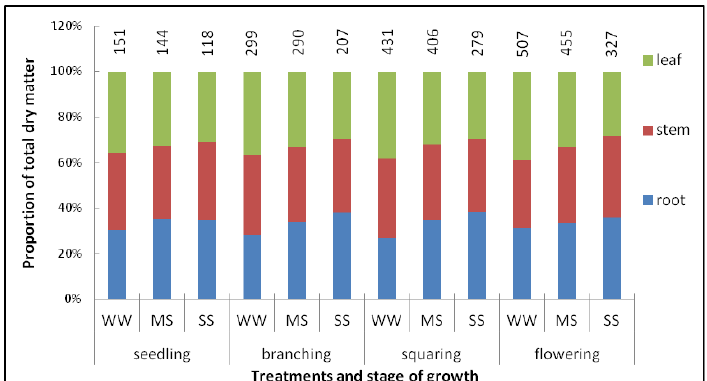
Figure 4. Effect of watering treatment (WW: water-sufficient (85% PC), MS: moderate water stress (65% PC), and SS: severe water stress (45% PC)) on the proportion of the total dry matter in the leaves, stems, and roots at the different growth stages: seedling, branching, squaring, and flowering. The values above the bars give the total dry matter (mg/plant) shown in Figure 3A.